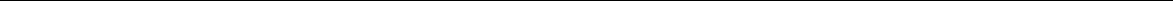
Fig. 5 Prioritizing genes and regulatory elements at the ATG16L1 locus for Crohn ’ s disease (CD) with a plausible regulation mechanism. a Results of SNP and SMR associations across mQTL, eQTL and GWAS. The top plot shows − log 10 ( P- values) of SNP from the GWAS meta-analysis for CD 40 . The red diamonds and blue circles represent – log 10 ( P- values) from the SMR tests for associations of gene expression and DNAm probes with CD, respectively. The solid diamonds and circles represent the probes not rejected by the HEIDI test. The yellow star indicates the previously reported causal variant rs2241880. The second plot shows − log 10 ( P -values) of the SNP associations for gene expression probe ILMN_1725707 (tagging ATG16L1 ). The third plot shows − log P- values) of the SNP associations for DNAm probe cg07618928. The bottom plot shows 14 chromatin state annotations (indicated by colours) of 10 ( 127 samples from REMC for different primary cells and tissue types (rows). b A hypothetical regulation mechanism. When the DNAm site in the enhancer is unmethylated, repressors can bind to the enhancer, decrease the activity of the promoter, and thus suppress the transcription of the ATG16L1 gene. When the DNAm site is methylated (by the effect of the genetic variant rs2241880 in the enhancer), the binding of repressors is disrupted, which prevents the transcription of ATG16L1 from